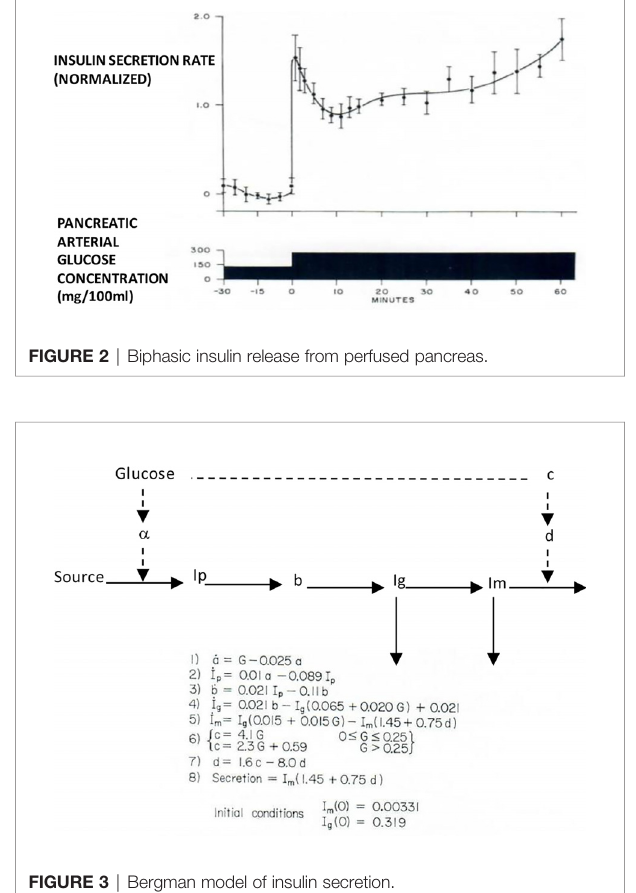
FIGURE 3 | Bergman model of insulin secretion.